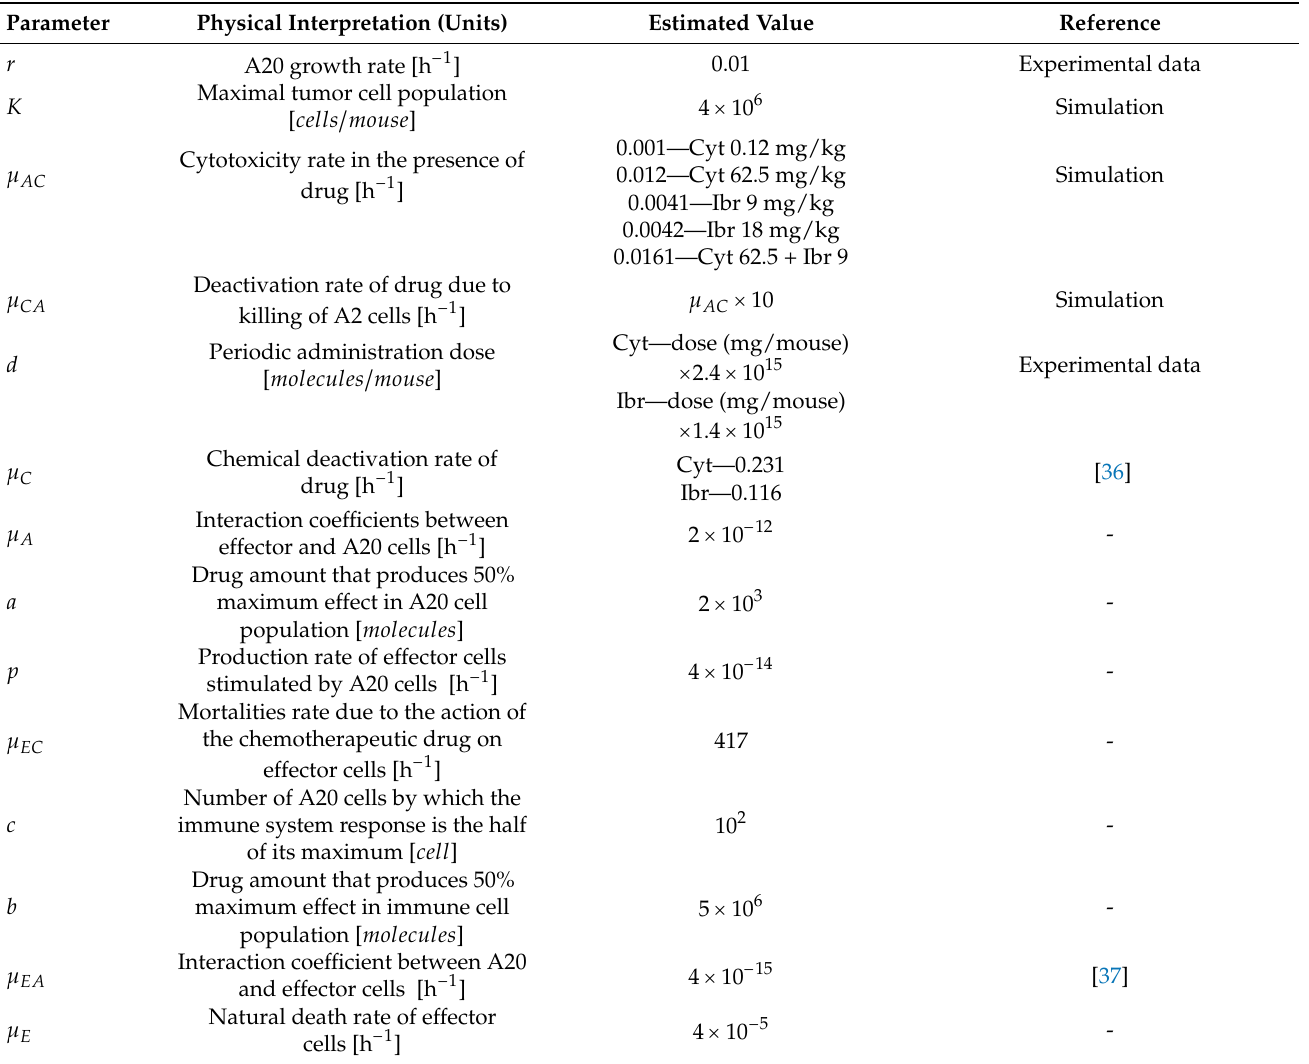
Table 1. Table of parameters based on experimental results related to the model of Equations